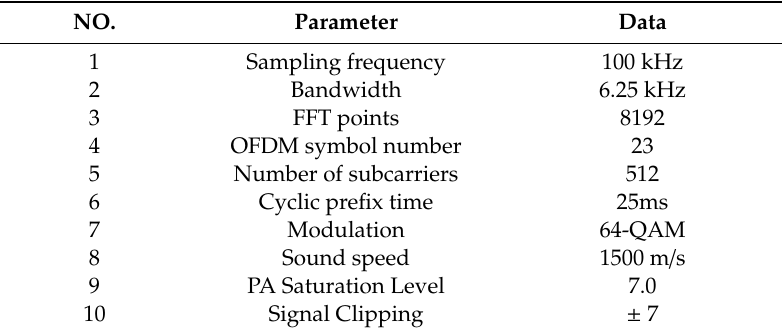
Table 1. Simulation system